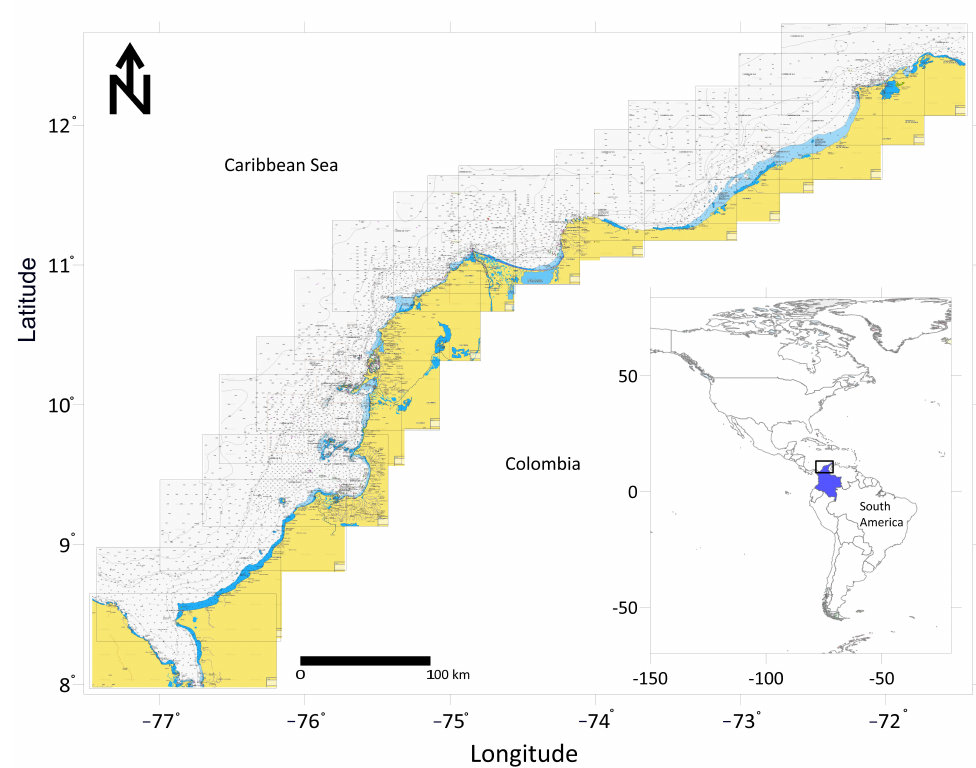
Figure 2. Mosaic of Navionics Sonar Chart bathymetric maps in